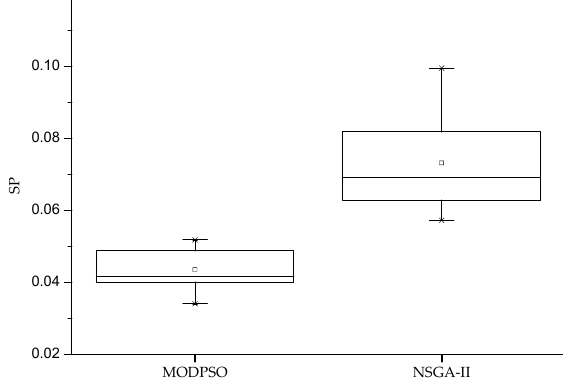
Figure 5. Distribution uniformity of Pareto optimal set of